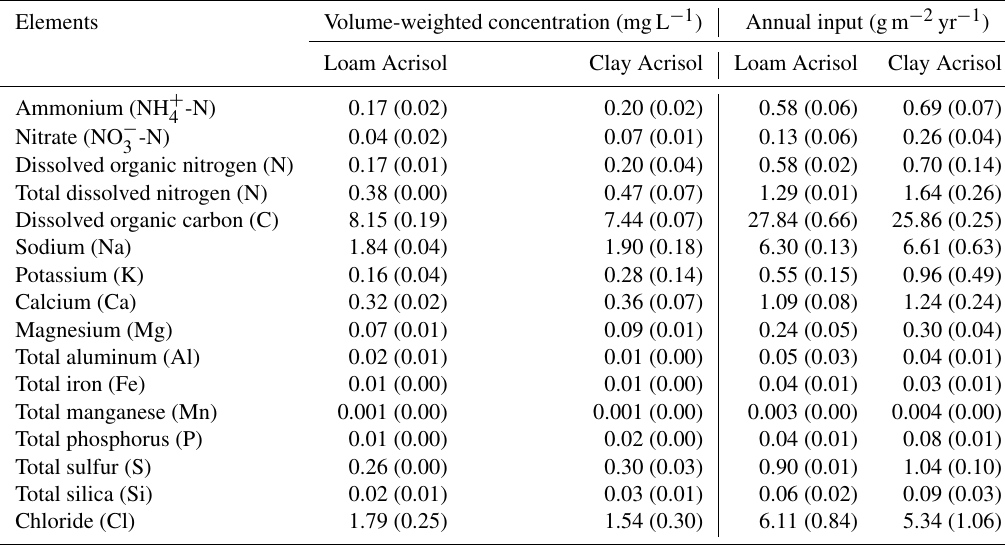
Table 2. Mean ( ± SE, n = 2) volume-weighted element concentrations and annual inputs in bulk precipitation measured biweekly to monthly from February to December 2013 in the two landscapes with loam and clay Acrisol soils in Jambi, Sumatra,